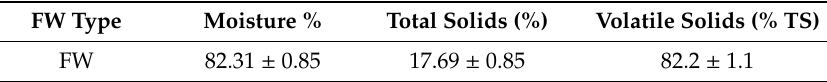
Table 1. Proximate analysis of the food waste (FW) investigated substrate, as a mixture of FWR and FWV.